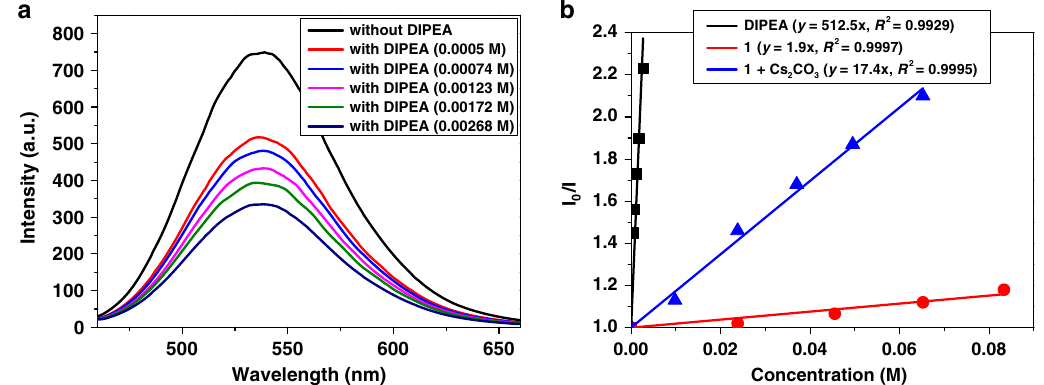
Fig. 7 Optical experiment with fl uorescence spectrum. a Steady-state Stern – Volmer experiment of 4CzIPN and DIPEA, the luminescence of 4CzIPN was readily quenched by DIPEA. b Stern – Volmer fl uorescence quenching experiments using 4CzIPN with DIPEA, 1 as well as 1 and Cs 2 CO 3